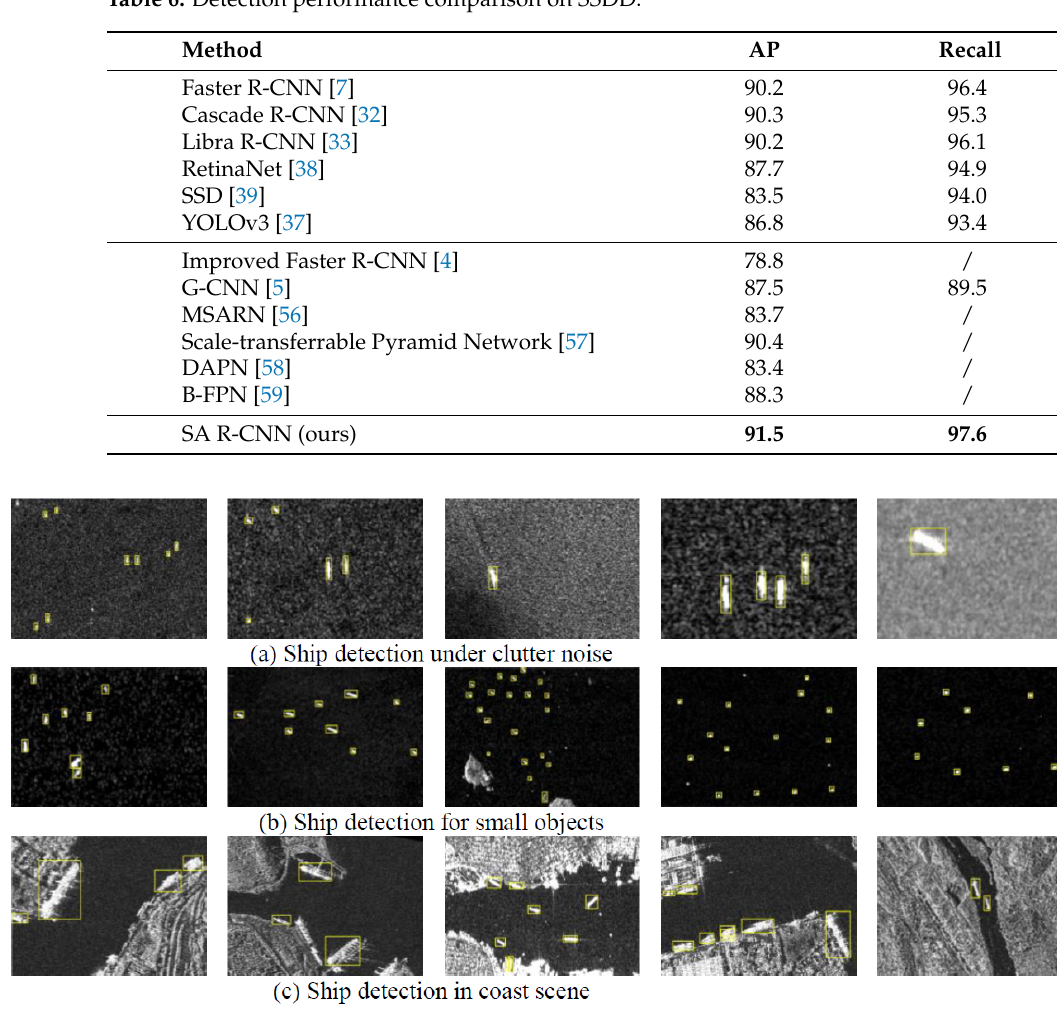
Figure 7. Ship detection performance of our SA R-CNN in three types of complex situations in the SSDD dataset with: ( a ) some noise or clutter; ( b ) a large number of small objects on the sea surface; and ( c ) a complex background around the